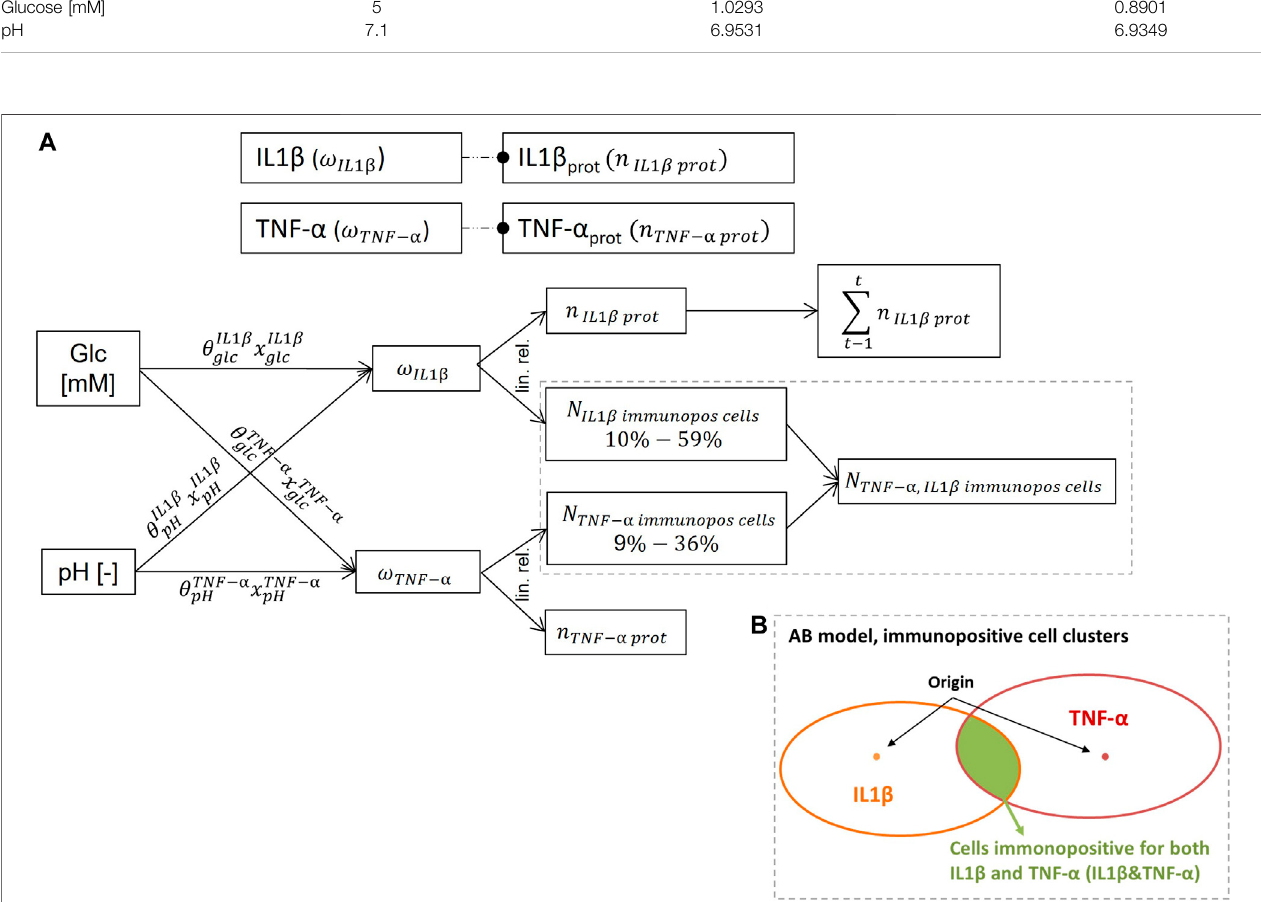
FIGURE 5 | In fl ammation submodel. (A) : underlying network of the schematically represented in fl ammation submodel in Figure 1 (top) , to approach mRNA expressions and protein synthesis of TNF- α and IL1 β . (B) : illustration of the determination of NP cells immunpositive for both, TNF- α and IL1 β by the agent-based (AB) model. Prot: protein, glc: glucose, immunopos: immunopositive, n: normalized, N: number, t: time, lin. rel.: linear